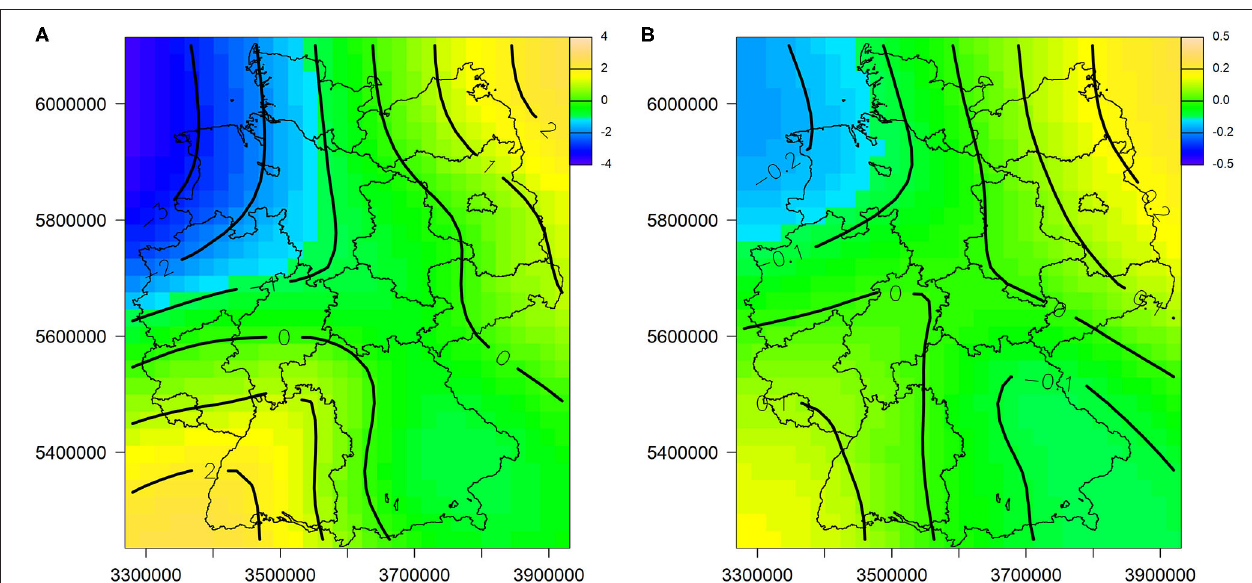
FIGURE 6 | Partial effect of geographic location on 1 TIN between the canopy budget and emission based method for wet deposition (A) and dry deposition (B) . Positive effects indicate a tendency for higher TIN deposition estimates of the CBM compared to the EBM. The values along the isolines indicate the impact on 1 TIN in kg ha − 1 a − 1 on the left and on 1 TIN in ln(kg ha − 1 a − 1 ) on the right side. The axes represent Gauss-Krüger